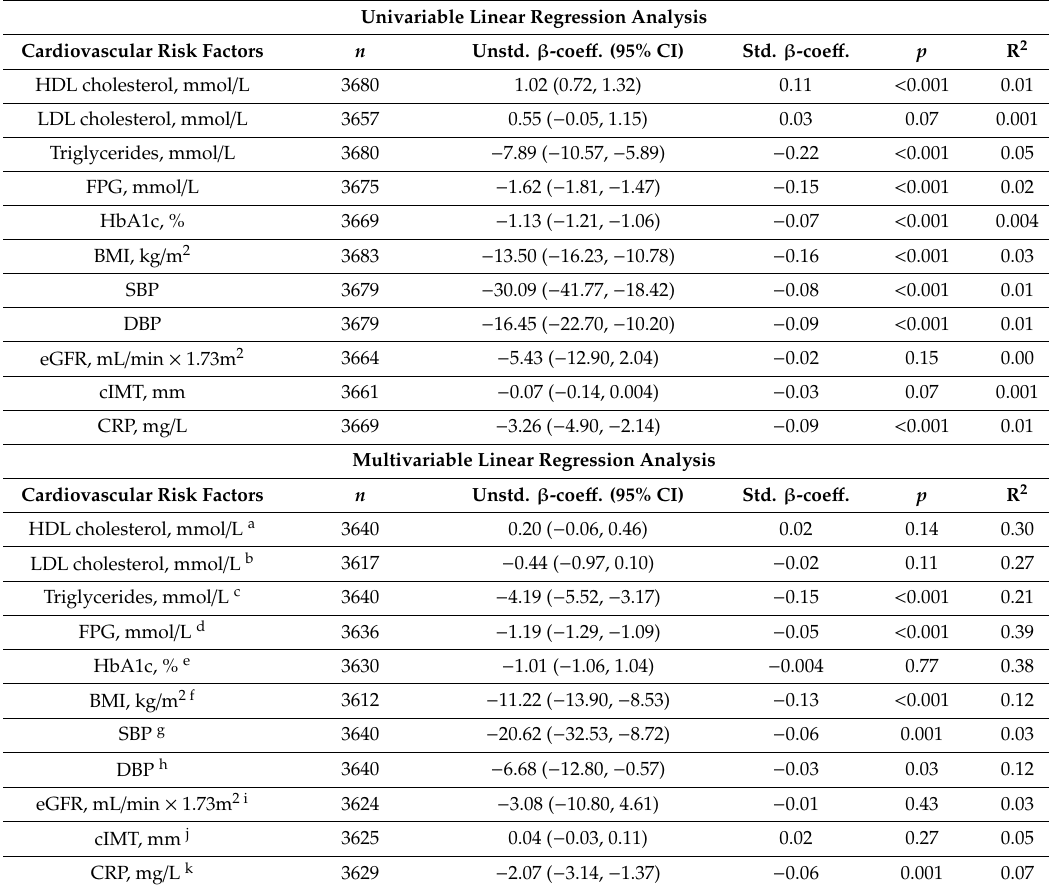
Table 2. Associations between plasma industrial trans fatty acid levels and cardiovascular risk factors. Univariable Linear Regression